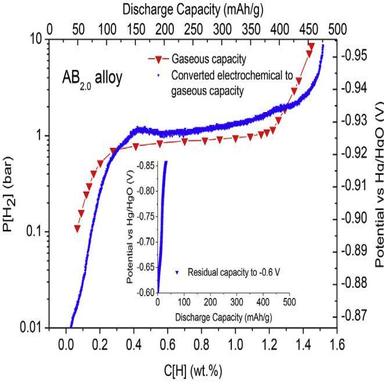
Gaseous capacity vs. electrochemical capacity for AB2.0 alloy. The inserts of the graphs show the tails of the curves measured from 0.85 to 0.6 V (cut-off voltage applied during the measurements of the discharge electrochemical capacity).